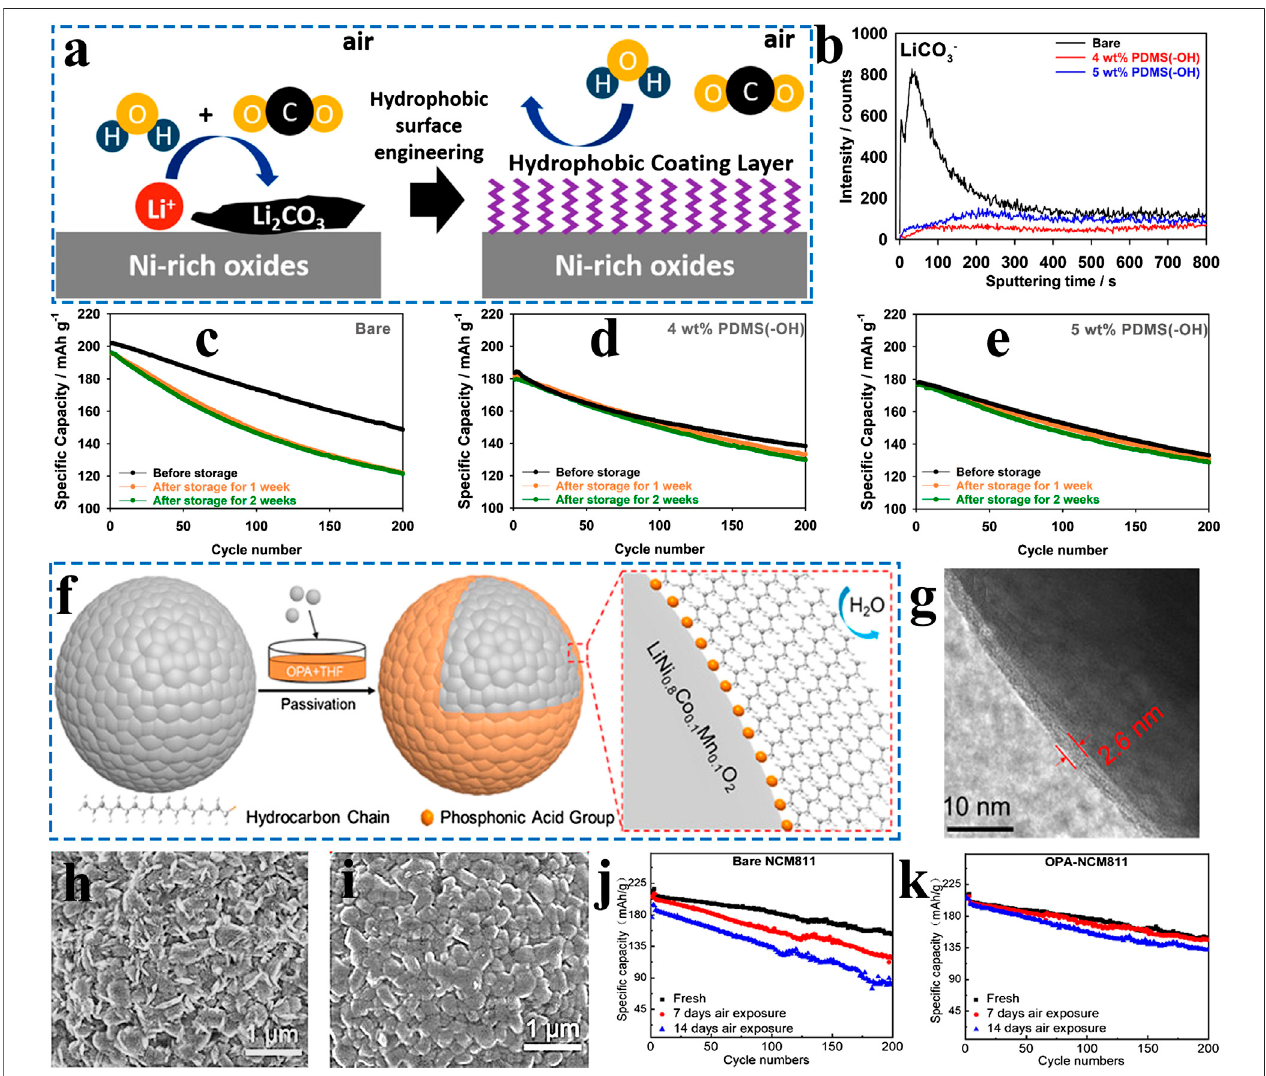
FIGURE5|(A) Schematic drawing ofthefunctionofsurfacehydrophobic coating layerand (B) TOF-SIMSdepthpro fi les ofLiCO 3 − for bare, 4 wt.%PDMS( − OH)- grafted, and 5 wt. % PDMS( − OH)-grafted LiNi 0.8 Co 0.1 Mn 0.1 O 2 powder samples after storage in a humidity chamber at 50% RH and 25 ° C for 1 week. (C-E) Cycling performances of bare, 4 wt. % PDMS( − OH)-grafted, and 5 wt. % PDMS( − OH)-grafted LiNi 0.8 Co 0.1 Mn 0.1 O 2 after being exposed to a humidity chamber at 50% RH and 25 ° C,respectively. Adapted from [Doo et al.,2019] withpermission fromAmericanChemicalSociety. (F) Schematic illustration ofthepreparationprocess ofOPA- coated NCM811 and (G) TEM images of OPA-coated NCM811; SEM images of (H) bare NCM811 and (I) OPA-coated NCM811 after 14-day air exposure; Cycling performance of (J) bare NCM811 and (K) OPA-coated NCM811 after different air exposure durations. Adapted from [Gu et al., 2020] with permission from American Chemical